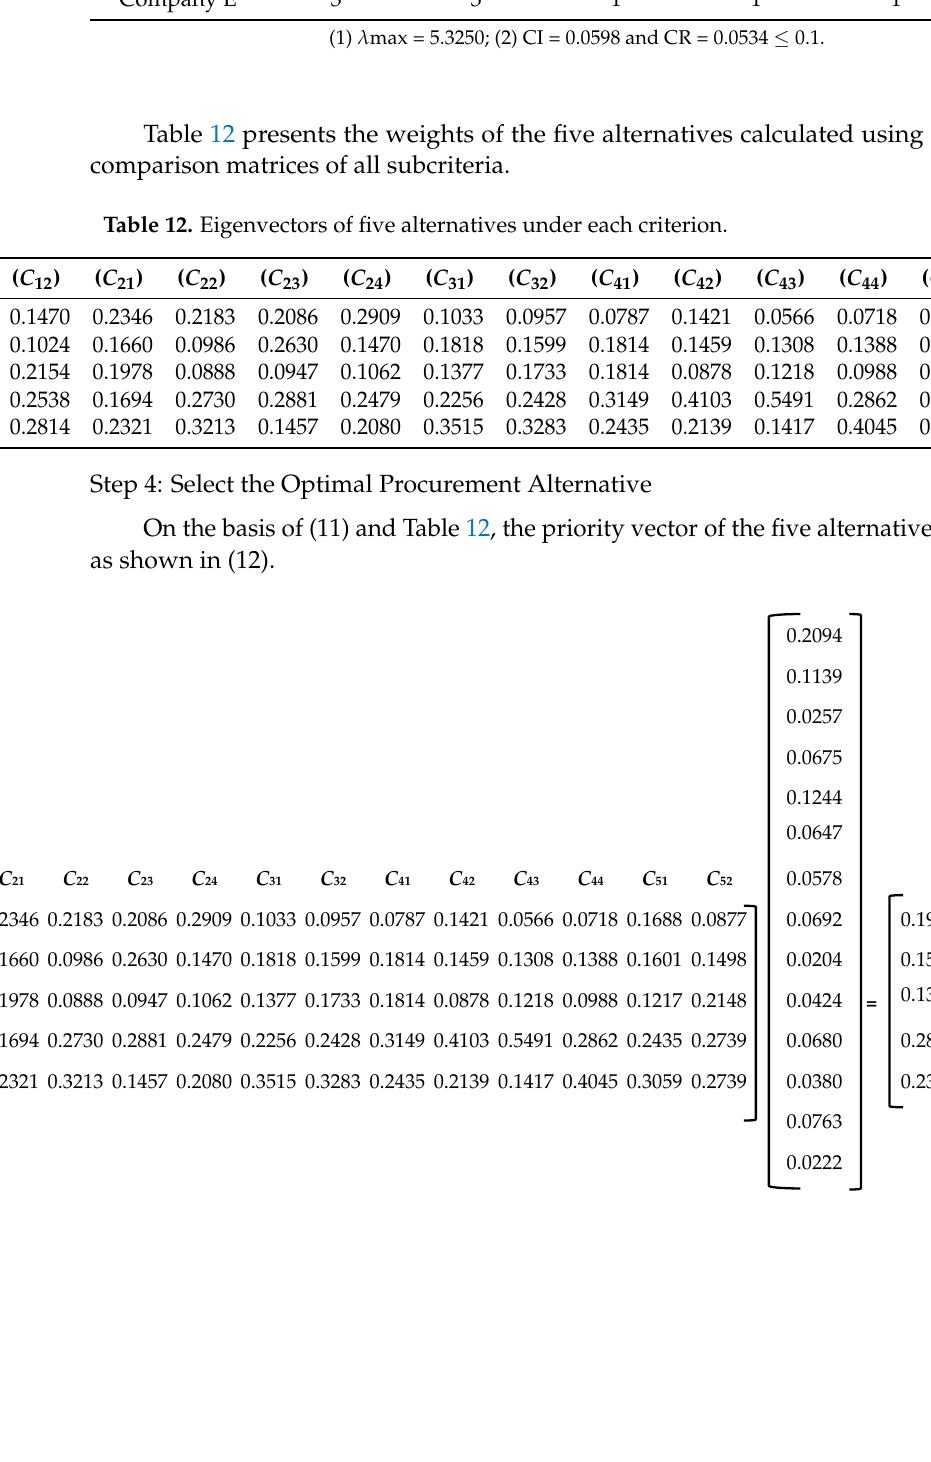
Figure 6. Ranking of alternatives for supplier selection. 5. Conclusions The continuous, rapid development of the e-commerce market has contributed to fast growth in the packaging industry and is allowing the CBPPM industry to thrive. Accord- ingly, the establishment of an appropriate CBPPM supplier selection decision-making model has become critical for corrugated box manufacturers to maintain their competitive advantage. According to the empirical results, Labib [6] considered product quality and delivery to be of greater importance than cost. Basnet [9] suggested that for both local and interna- tional businesses, quality, the ability to deliver on time, and performance are the